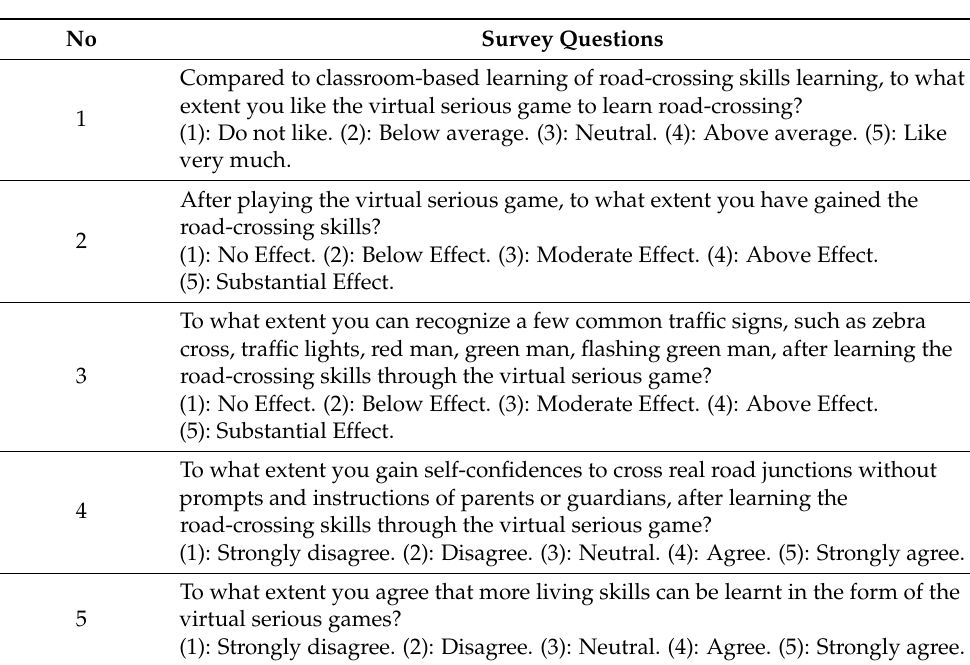
Table 3. Simple survey questionnaires after gameplay.